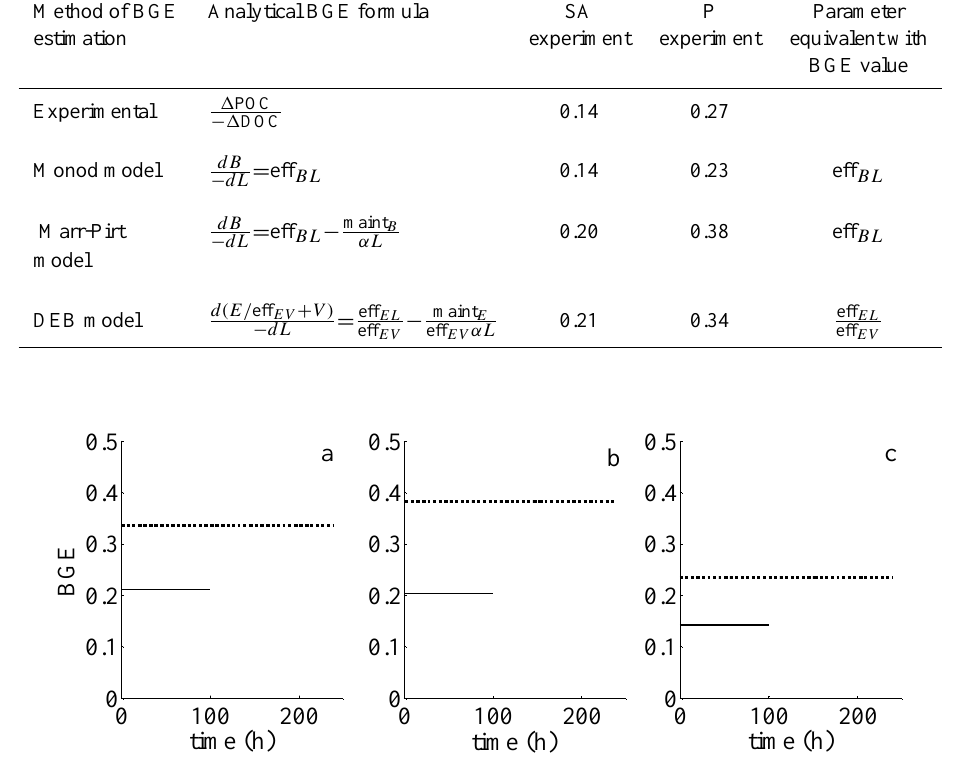
Table 4. Summary of the different formulae used to estimate BGE, directly from data points (experimental) or with three models (Monod, Marr-Pirt and DEB models) for the SA and P experiments, and their corresponding values. The right side of the analytical formulae has been calculated with equations of each model (Eqs. 1–3). The last column represents parameters of each model to which BGE values corresponds analytically (see Fig. 5).